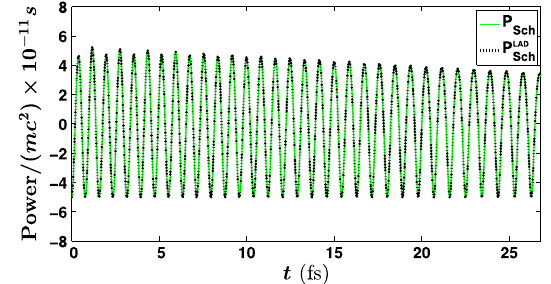
ð t Þ and P LAD ð t Þ for the uniform Sch Sch